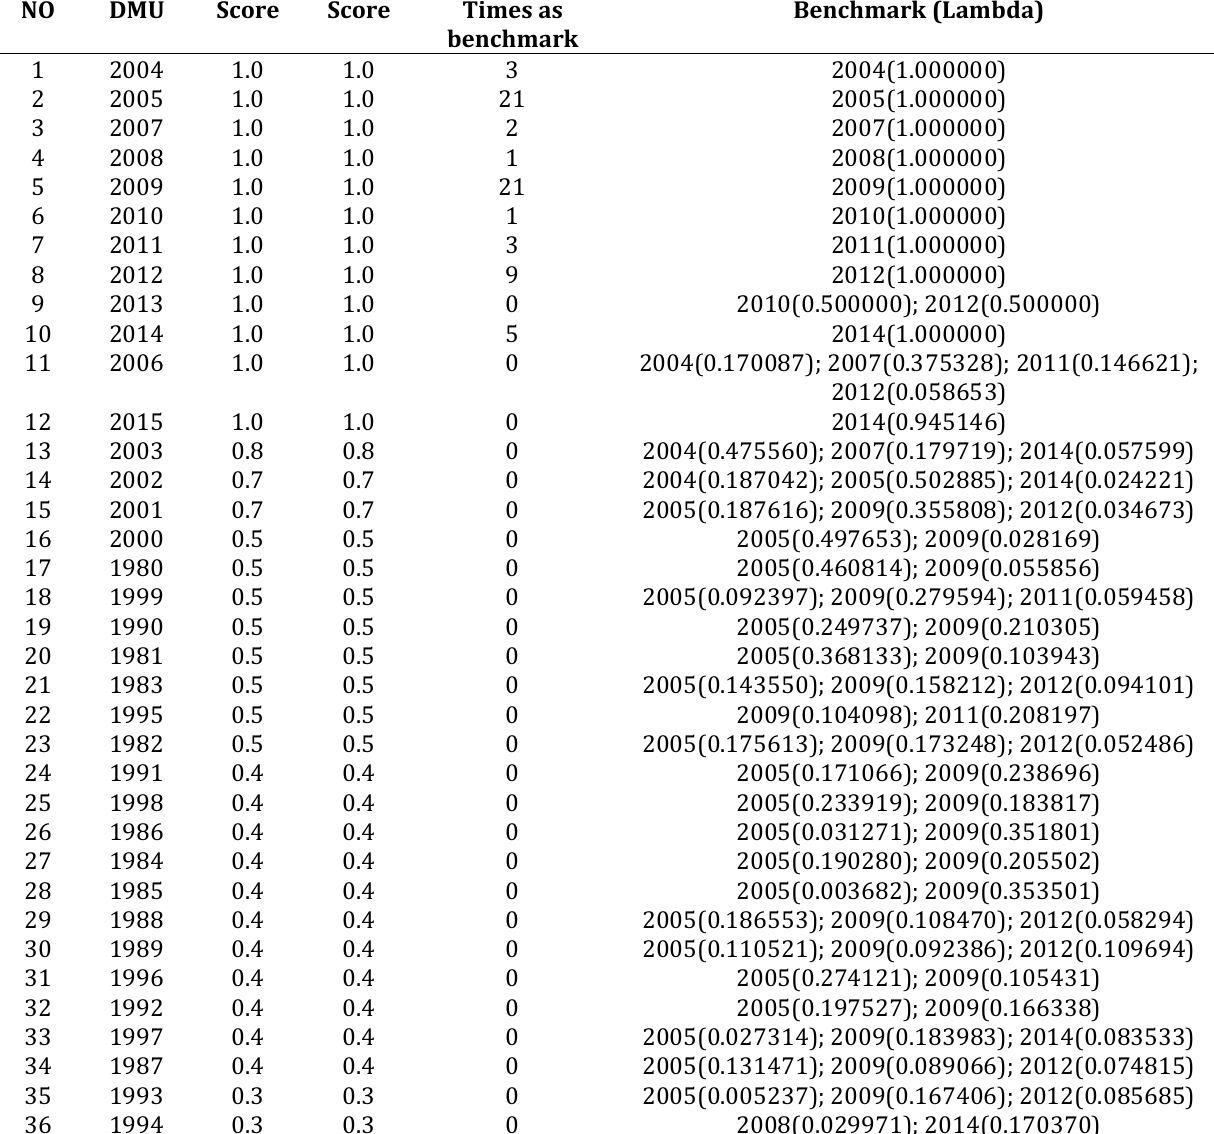
Table 9: Input-Oriented Technical Efficiency Benchmarking for Onne Port